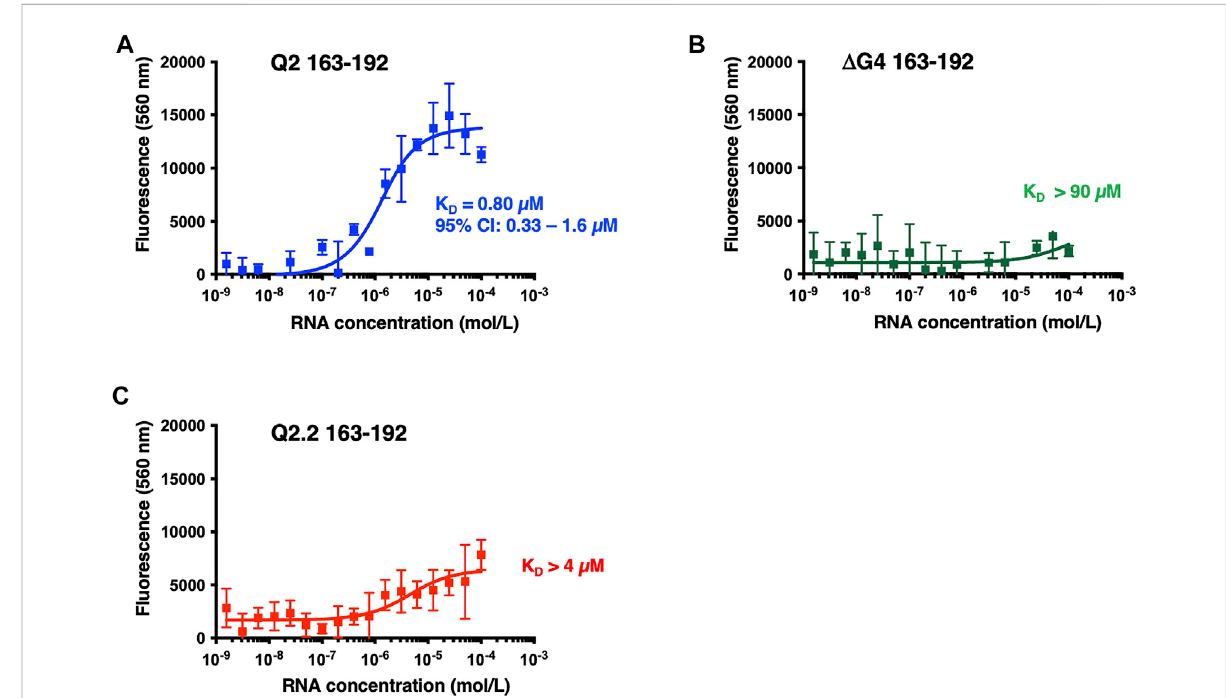
FIGURE 7 Fluorescence emission at 560 nm ( λ exc = 320 nm) of GQC-05 as a function of the Bcl-x fragments in the presence of HeLa nuclear extract. Single-site fl uorescence binding isotherms of 1 µM GQC-05 incubated with varying concentrations of Q2 163 – 192 (A) , Δ G4 163 – 192 (B) and Q2.2 163 – 192 (C) . Experiments were conducted in 10 mM Tris pH 7.0, 100 mM KCl and 10% HeLa nuclear extract, at 20 °